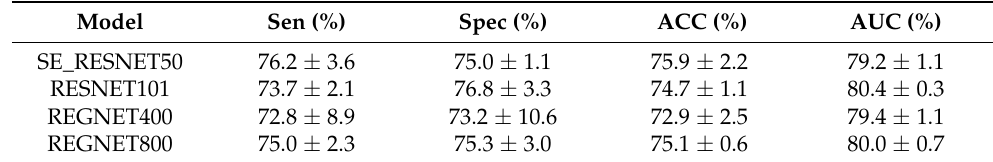
Table 5. Performance of four types of basic models with mixed loss and sample reweighting methods in the validation cohort.